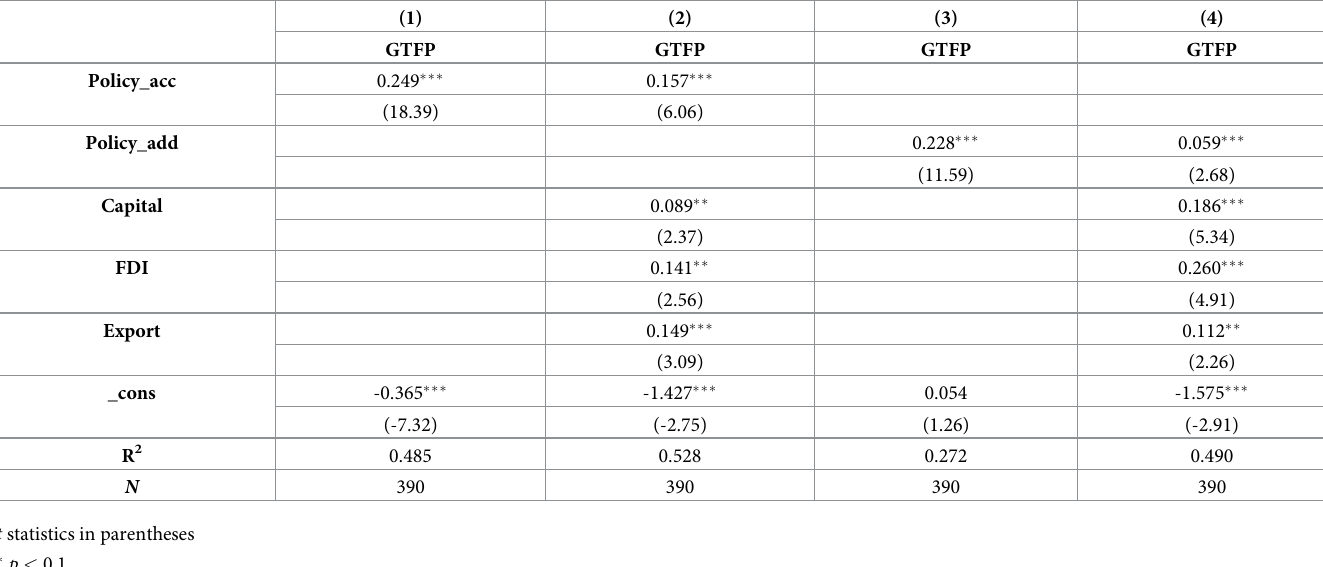
Table 2. Benchmark regression: Fixed-effects